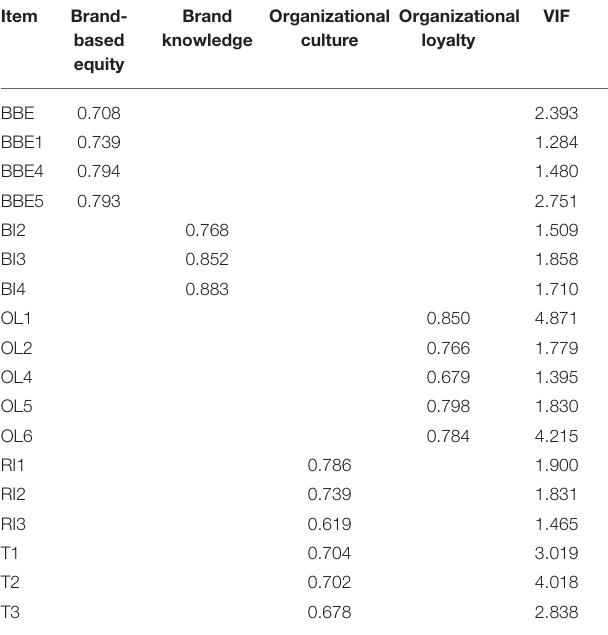
TABLE 2 | Outer loadings and variance inflation factor